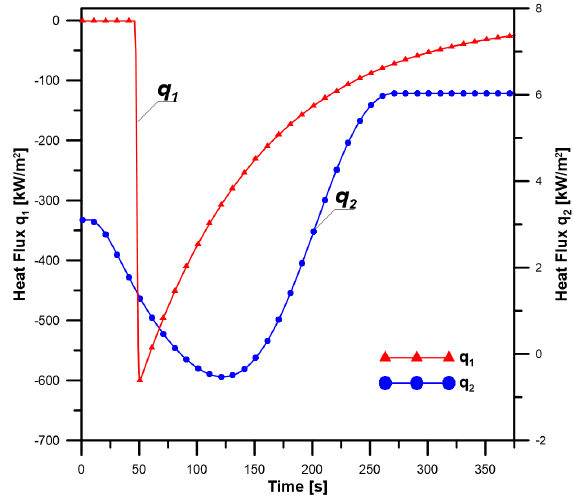
Figure 20. The assumed heat fluxes for the uncertainty analysis.